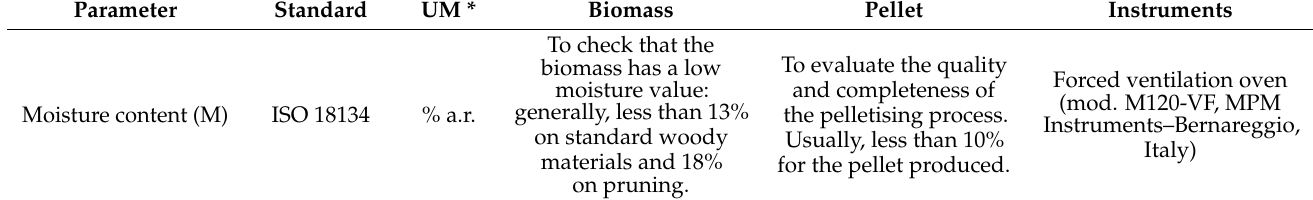
Table 2. Parameters analysed on biomass materials and pellet and standards